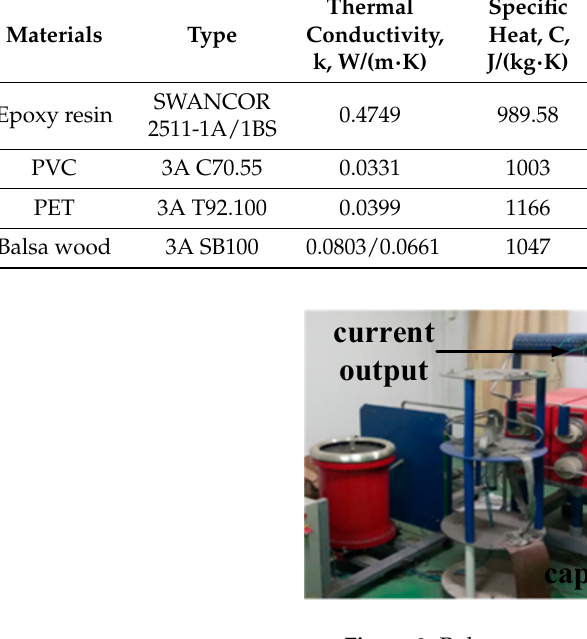
Figure 3. Pulse current generator.